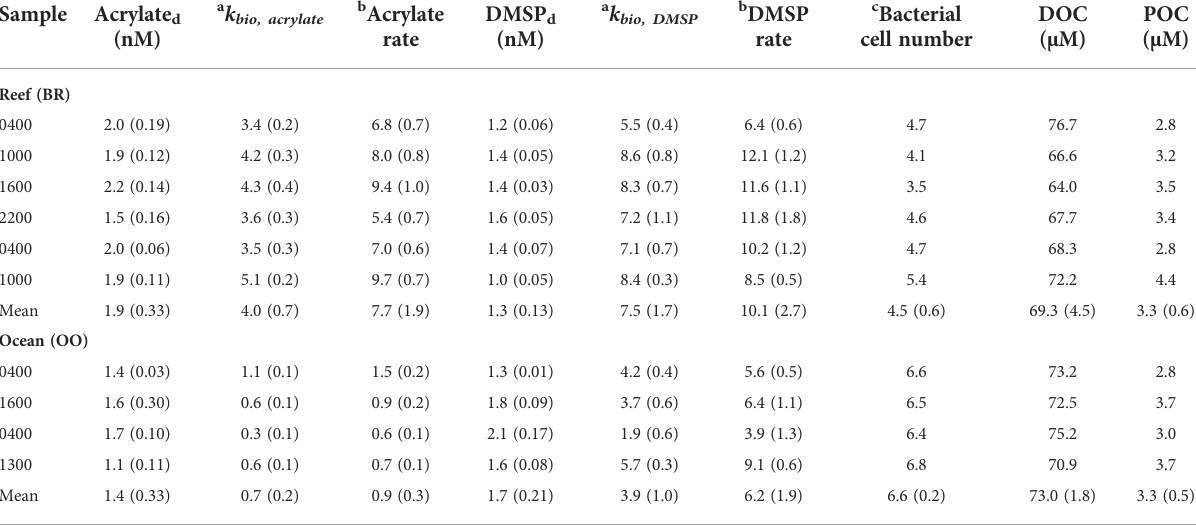
TABLE 4 Ambient dissolved acrylate and DMSP concentrations, dissolved organic carbon (DOC), particulate organic carbon (POC), and biological rate constants and consumption rates of acrylate and DMSP in the coral-reef BR station and open-ocean OO station collected during diel sampling; local sampling times are reported in the sample